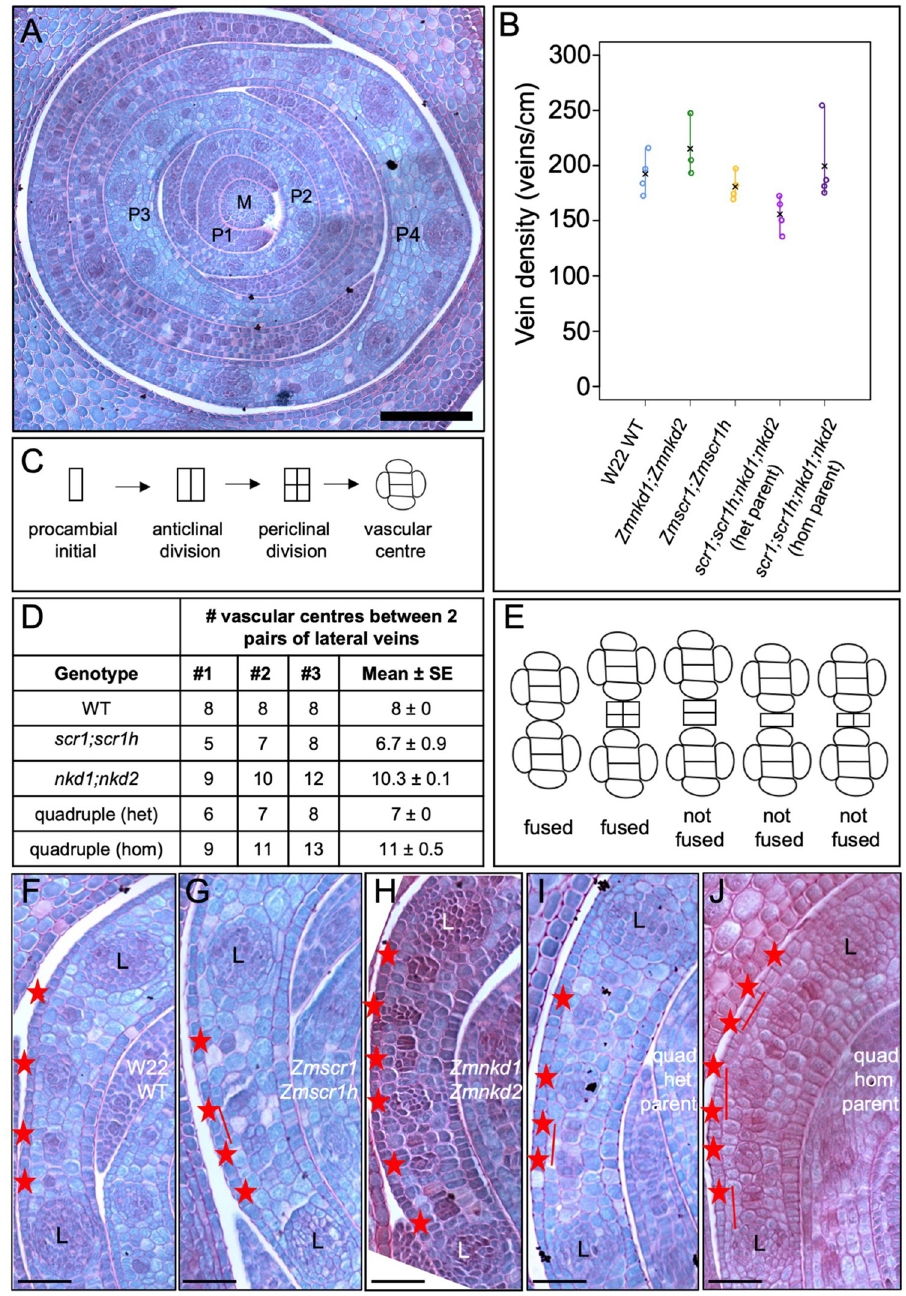
Fig 8. Embryonic leaf phenotypes reveal patterning defects during embryogenesis. A) Transverse section of a wild- type (WT) W22 embryo taken across the tip of the meristem (M), such that P1-P4 leaf primordia are visible. Scale bar: 100 μ m. B) Quantification of vein density in P4 primordia. Open circles indicate measurements from independent biological replicates, and black crosses indicate the mean for each genotype (raw data in S1 Table). C) Schematic of rudimentary cell division patterns seen in the innermost ground meristem layer of the leaf as procambium is initiated to form intermediate veins. D) Number of vascular centres observed between two pairs of lateral veins (one each side of the midvein) in P4 primordia of three mature embryos for each genotype. Data sourced from images in S10 Fig. E) Schematic showing criteria used for scoring fused vein phenotype. Vascular centres were not scored as such unless both an anticlinal and periclinal division had occurred. F-J) Representative transverse sections of P4 primordia from WT W22 (F), Zmscr1-m2;Zmscr1h-m1 (G), Zmnkd1-Ds;Zmnkd2-Ds (H), Zmscr1-m2;Zmscr1h-m1;Zmnkd1-Ds; Zmnkd2-Ds from a heterozygous NKD/nkd parent (I) and Zmscr1-m2;Zmscr1h-m1;Zmnkd1-Ds;Zmnkd2-Ds from